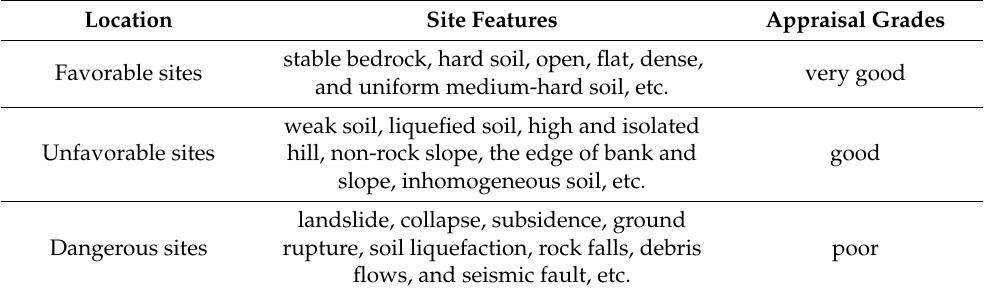
Table 4. Evaluation index of seismic performance.